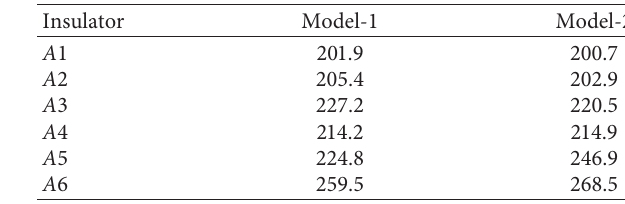
Table 5: Model material parameters.